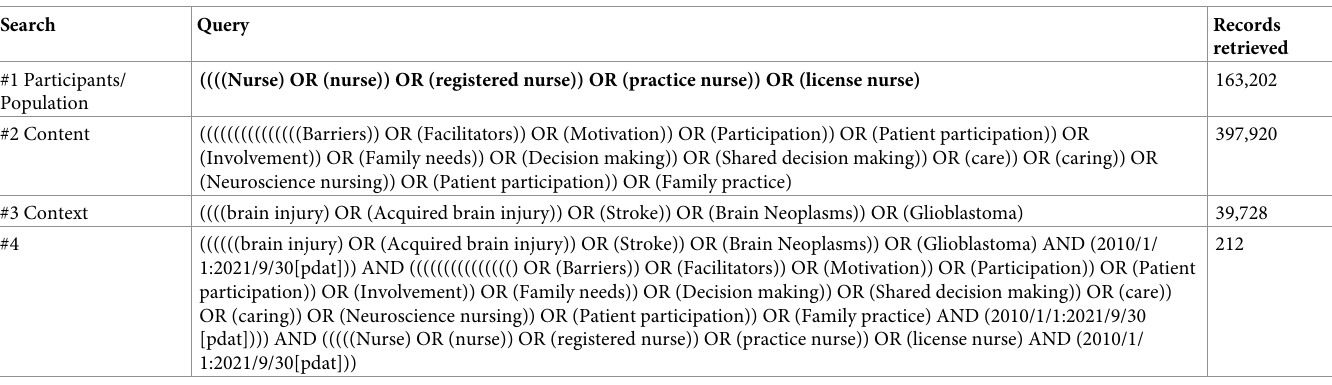
Table 2. Initial search strategy for Medline (via PubMed).